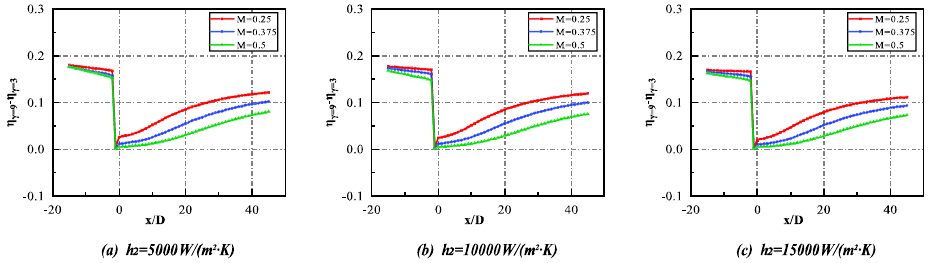
Figure 12. Distribution of (cid:0) η γ = 9 − η γ = 3 (cid:1) under different BRs and h 2